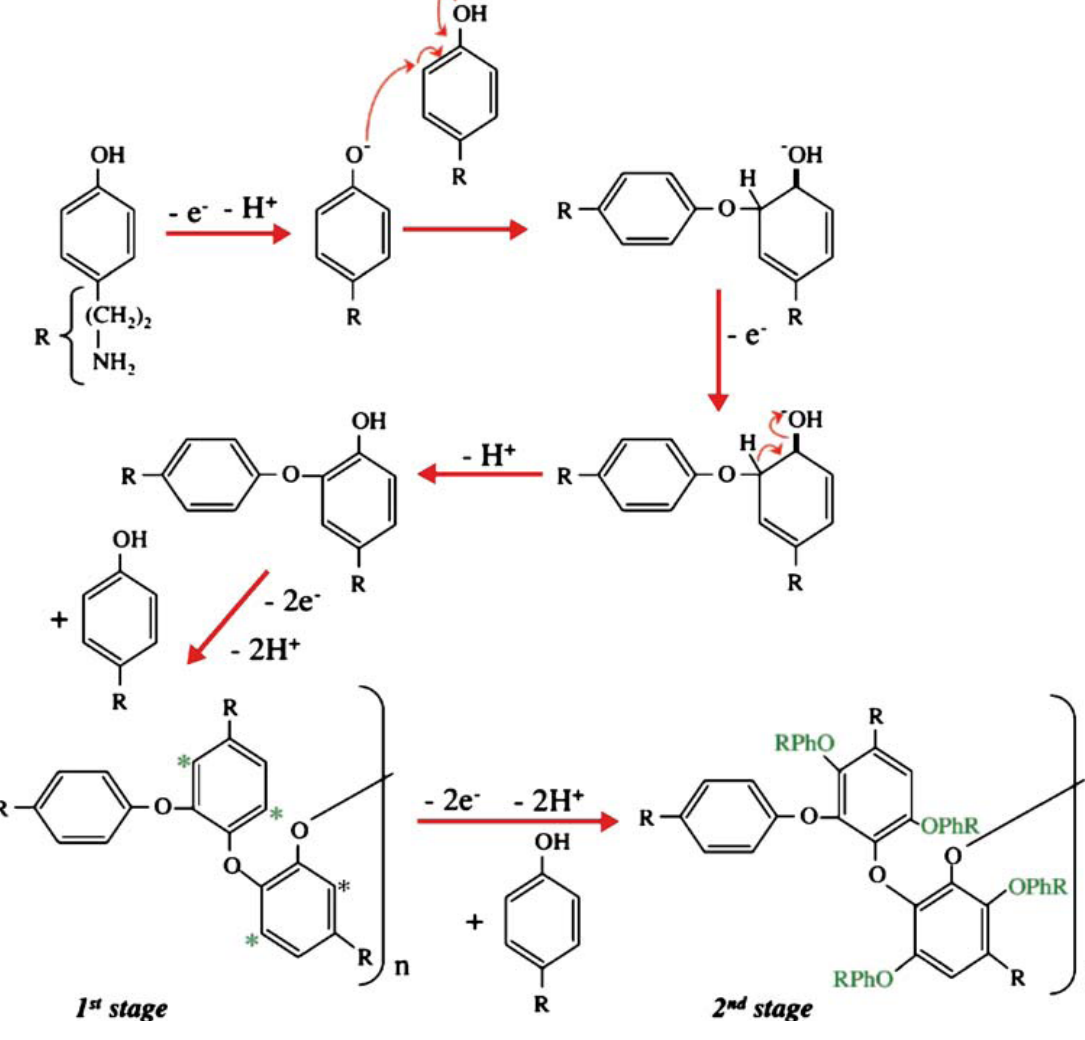
Figure 2. Electrode mechanism for polymerisation of tyramine. Reproduced from